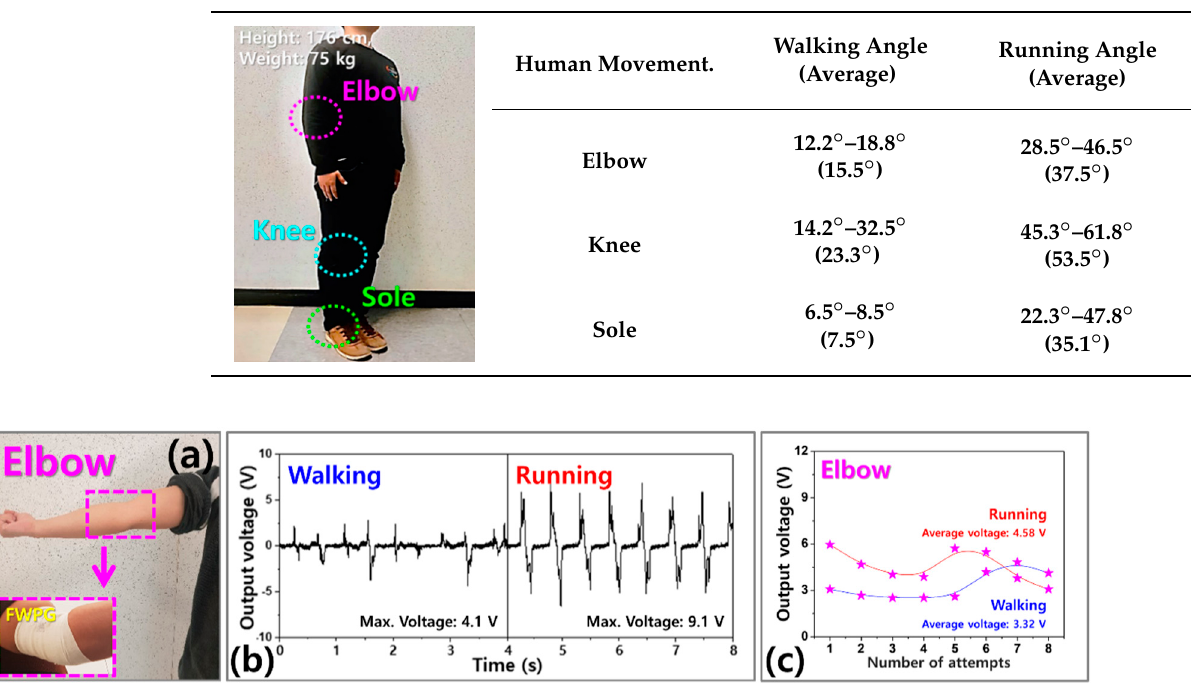
Table 3. Experimental set up to measure the angle change according to walking and running angles from the elbow, knee, and sole.